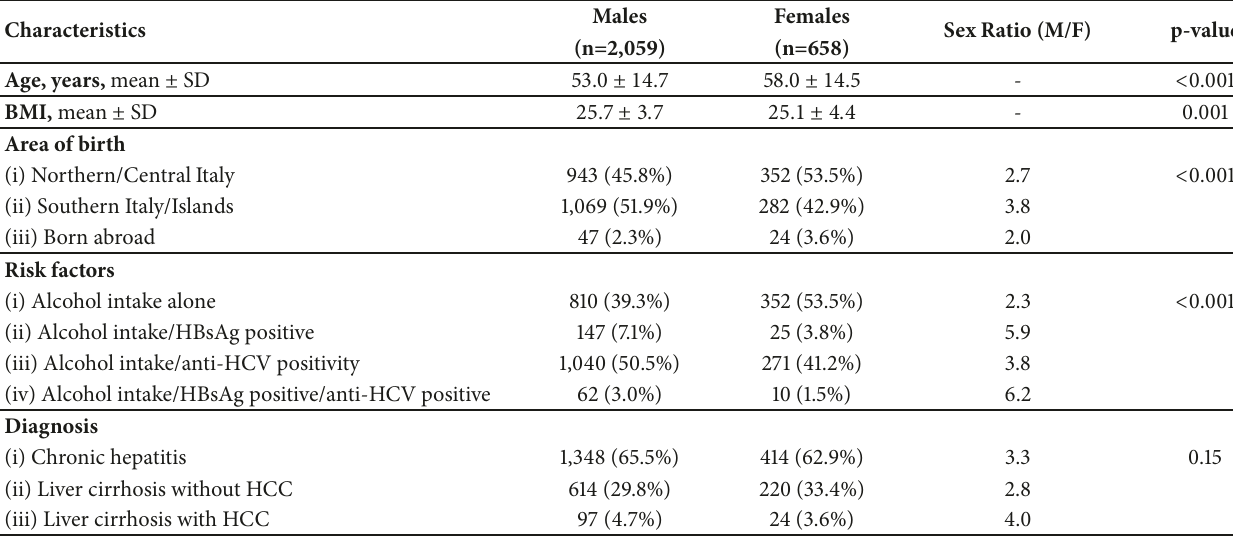
Table 2: Characteristics of 2,717 enrolled subjects with chronic liver disease alcohol related in Italy, by sex.